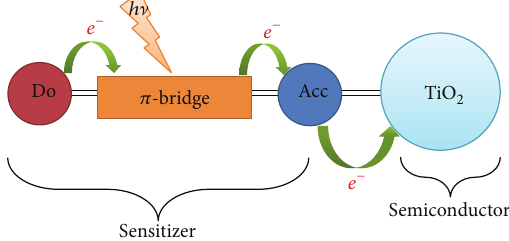
Figure 4: Design mechanism of the use of an organic dye for TiO 2 photoanodes in DSSCs